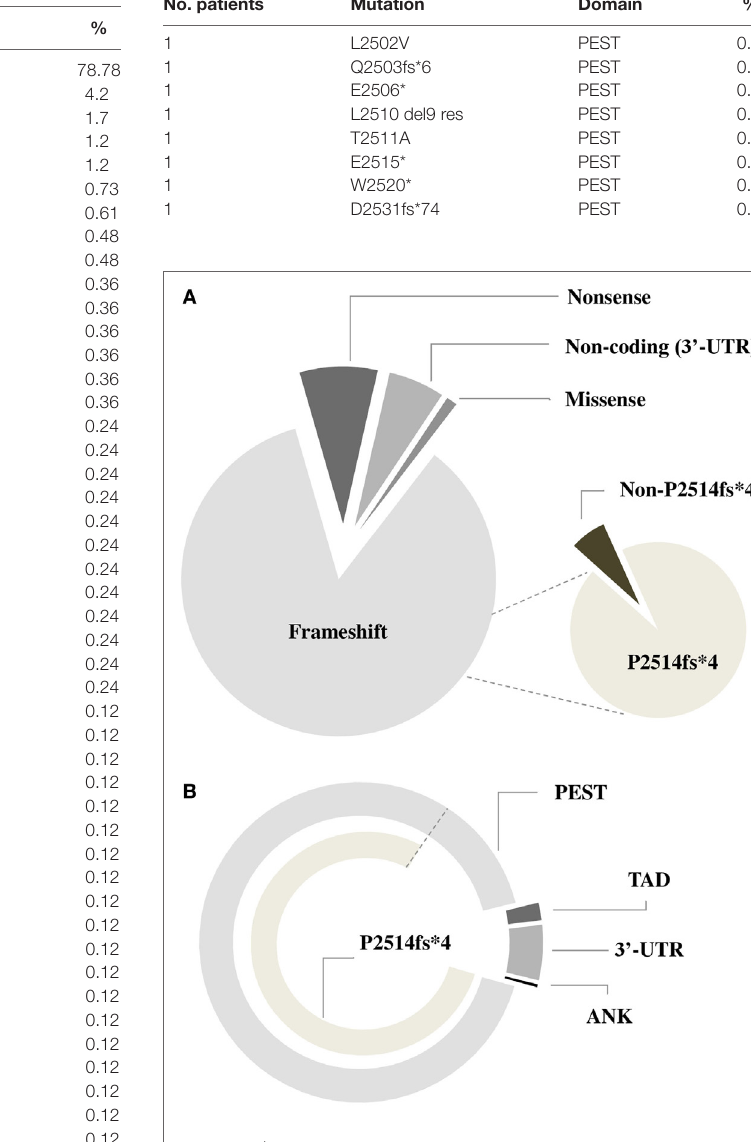
FigURe 3 | Frequency of different types of NOTCH1 mutations in chronic lymphocytic leukemia. Pie charts describing the incidence of NOTCH1 mutations according to the type of genetic variant (A) and domains (B) involved.